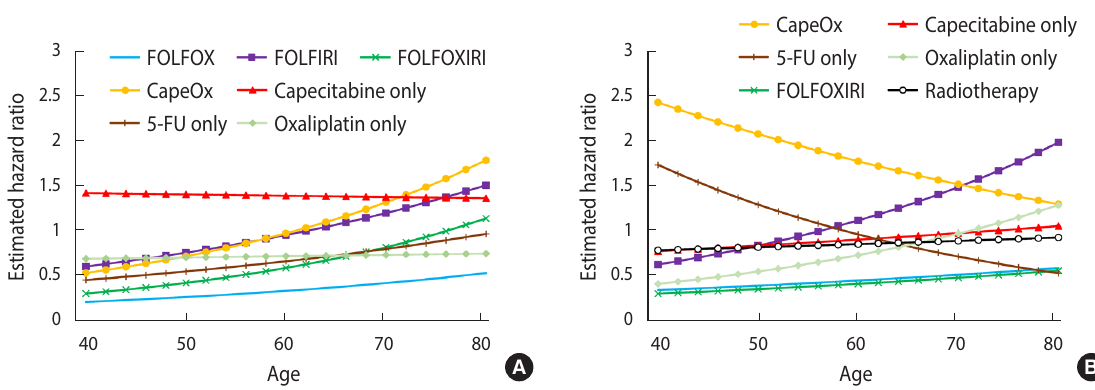
Figure 3. Age-specific hazard ratios of chemotherapy regimen and radiotherapy for cognitive impairment (A) colon cancer and (B) rectal cancer. FOLFOX, folate, 5-fluorouracil (5-FU), oxaliplatin; FOLFIRI, folate, 5-FU, irinotecan; FOLFOXIRI, folate, 5-FU, oxaliplatin, irinotecan; CapeOx: capecit abine,